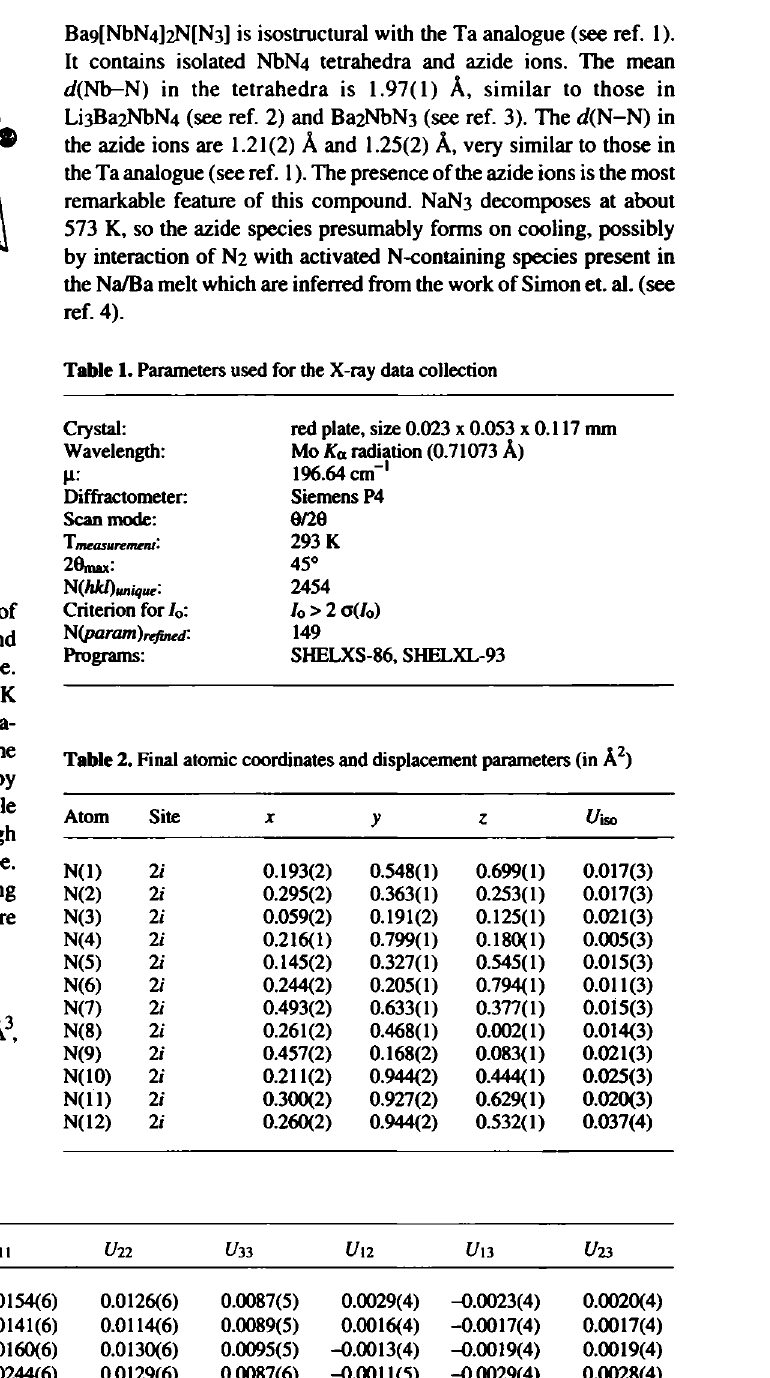
Table 3. Final atomic coordinates and displacement parameters (in Â 2 ) Atom